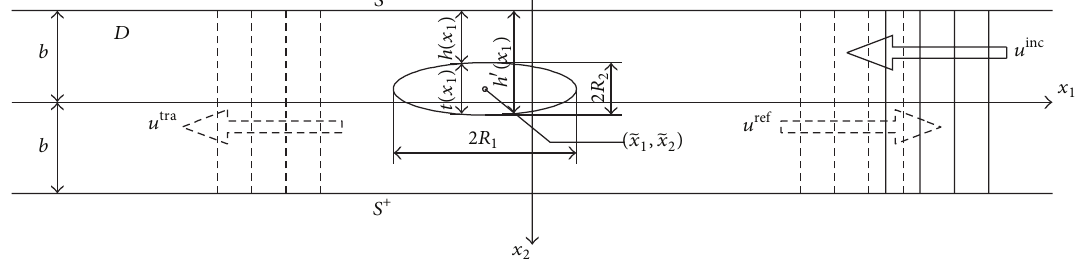
Figure 1: Schematic of the inverse